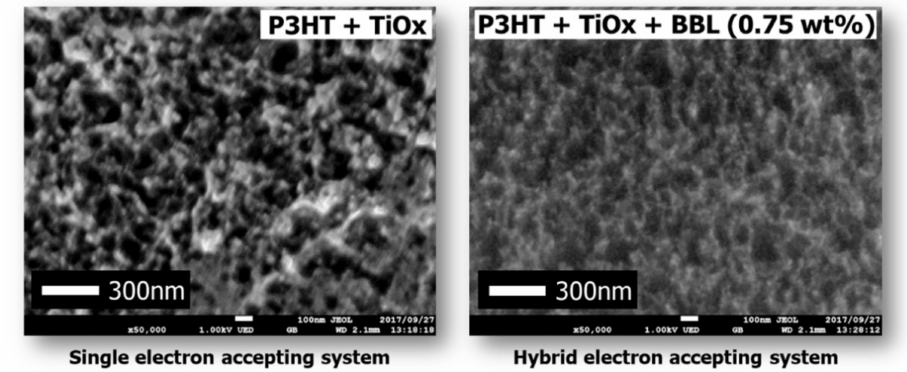
Figure 6. SEM images of photoactive